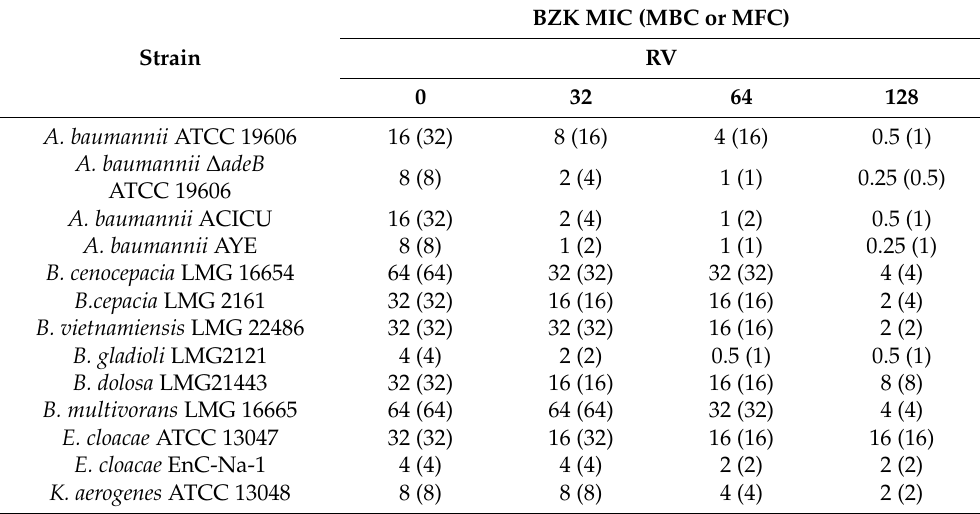
The numbers outside and within the brackets indicate MIC and MBC or MCF values, respectively, and are expressed in mg/L. The numbers 0, 32, 64, 128 and 256 indicate RV concentrations and are expressed in mg/L. Furthermore, increasing the doses of RV up to 128 mg/L decreased dose-dependently the BZK MIC and MBC (MCF for Candida spp.) and restored the BZK susceptibility in most of the strains, but not B. cenocepacia LMG16654, B. dolosa LMG21443, B. multivorans LMG16654, E. cloacae ATCC 13047, K. pneumoniae ATCC 700603, S. maltophilia K279 or all of the P. aeruginosa strains (Table 3). A positive correlation was also found between the RV effect on BZK MIC and the MBC and CCCP effect on BZK MIC and MBC (Tables 1 and 3; Figure S2, Supplementary Materials) (r = 0.775, p < 0.01), thus suggesting that the inhibition of the EPs activation might be involved in the inhibitory effect of RV on tolerance to BZK. This is in agreement with a previous publication that showed that RV inhibited basal and CHX-induced expression of the AdeB RND superfamily and the AceI PACE superfamily EP systems in A. baumannii [19]. Table 3. Effect of RV (mg/L) on BZK MIC (mg/L) and MBC (MFC in the case of Candida spp.) (mg/L) against Gram-negative bacteria, Gram-positive bacteria and yeasts. BZK MIC (MBC or Strain